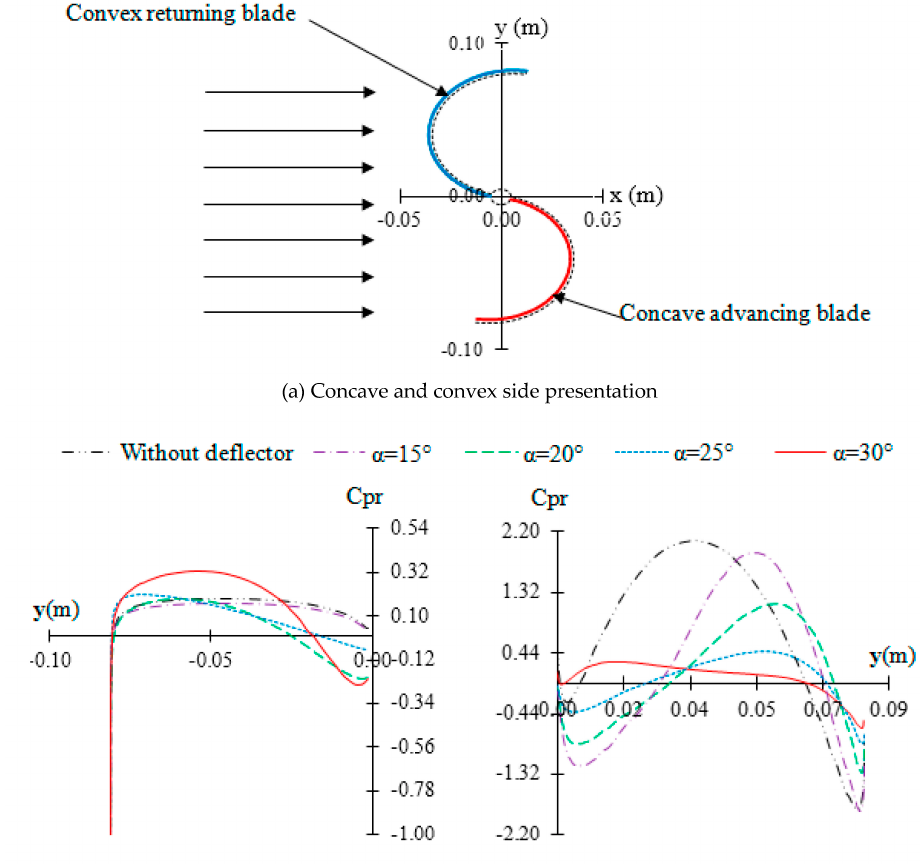
Figure 14. Pressure coefficient distribution for different deflection angles.